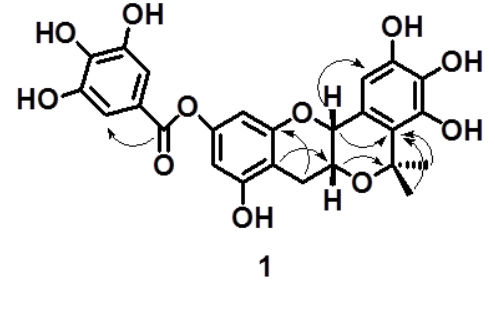
Figure 2. The key HMBC correlations of compound 1